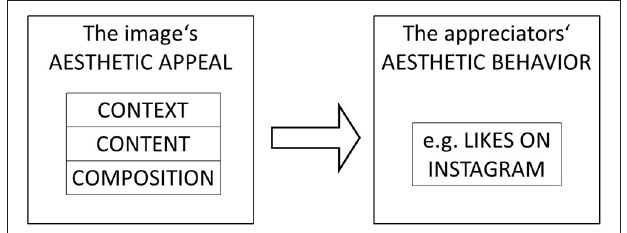
FIGURE 1 | The aesthetic appeal of an image is determined by its content, its composition, and the context. Instagram Likes are interpreted as aesthetic behavior in the sense of Berlyne (1971) that are tied to the aesthetic appeal of an